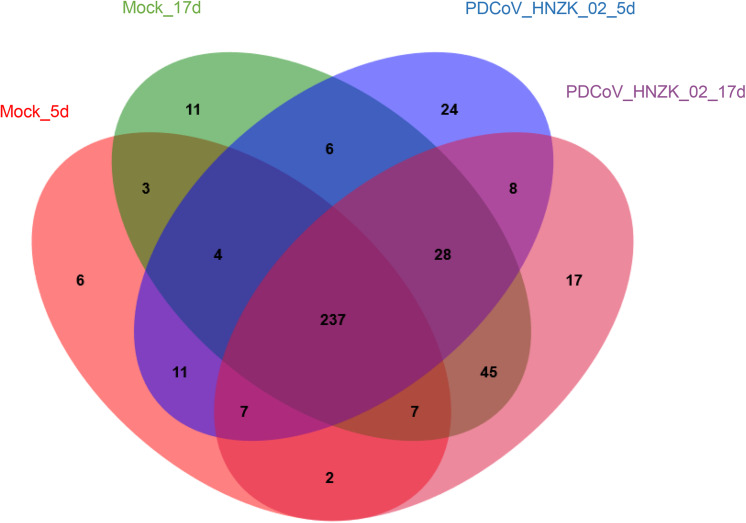
Venn map. Venn map of shared OTUs based on the sequences with more than 97% similarity (n = 3). The mock group at 5 dpi (mock-5d), the PDCoV HNZK-02 group at 5 dpi (HNZK-02-5d), the mock at 17 dpi (mock-17d), and the PDCoV HNZK-02 group at 17 dpi (HNZK-02-17d).